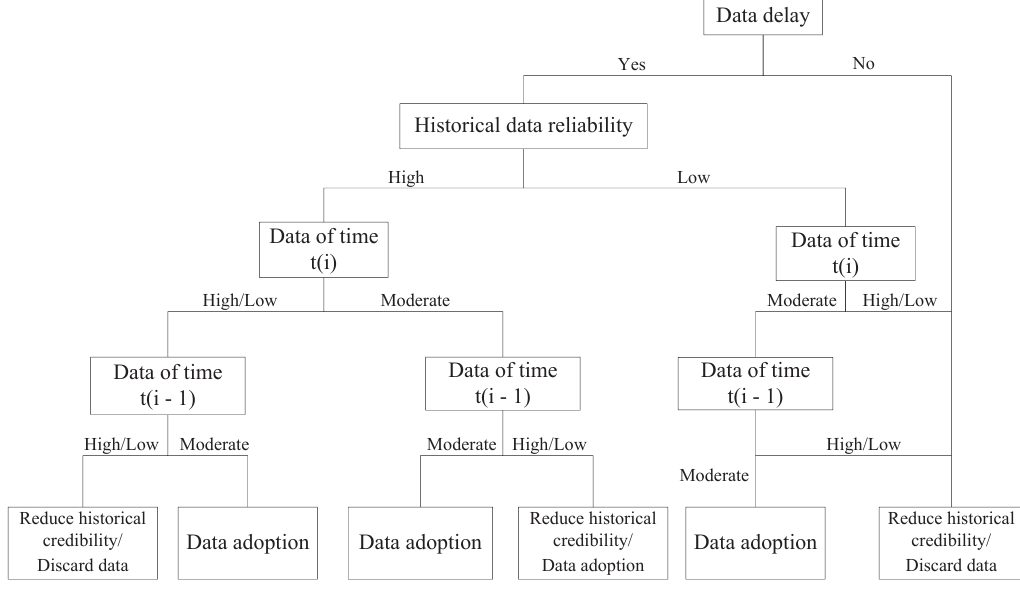
Figure 6. The architecture of the improved onboard safety computer